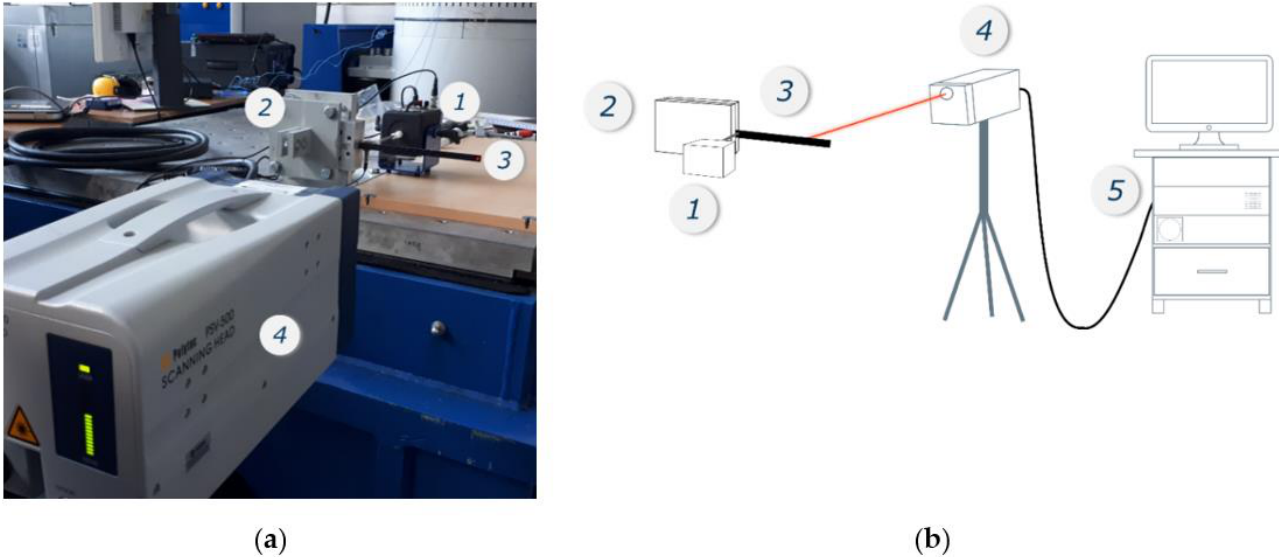
Figure 1. View of the test stand ( a ); schematic diagram of the laser vibrometer components ( b ). Parts of the measurement system: electro dynamic shaker ( 1 ), support of the beam ( 2 ), sample ( 3 ), PSV-500 scanning head ( 4 ), and OFV-500 controller ( 5 ).